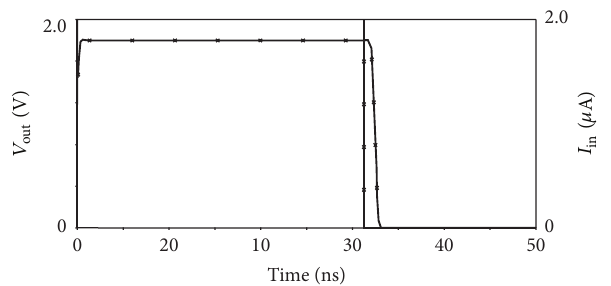
Figure 4: Output for proposed comparator for input current differ- ence of 2 𝜇